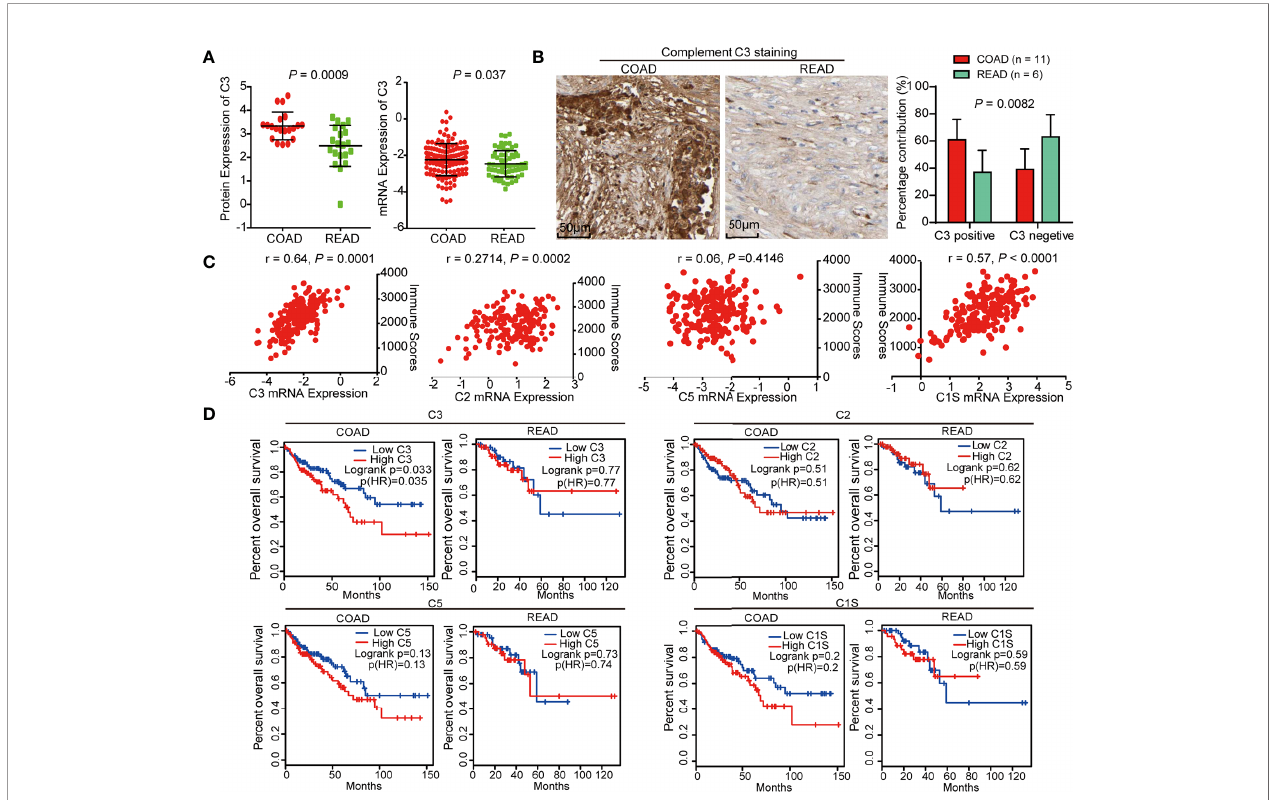
FIGURE 5 | C3 is negatively correlated with overall survival of colon adenocarcinoma (COAD) patients. (A) The protein and mRNA level of C3 in COAD were higher than READ. (B) IHC staining of C3 in COAD and rectal adenocarcinoma (READ) using Human Protein Atlas, statistical analysis using IHC pro fi ler plug-in of Image J software showed that C3 expression was signi fi cantly increased in COAD tissues as compared with READ. (C) The scatter plot showing the correlation between mRNA expression of C3, C2, C5, and C1S and immune scores, respectively. Only C3 exhibited signi fi cant correlation with immune scores. (D) Kaplan-Meier curves from GEPIA described that C3 expression is negatively correlated with overall survival of COAD patients but not READ. C2, C5, C1S expression were not signi fi cantly correlated with overall survival of both COAD and READ